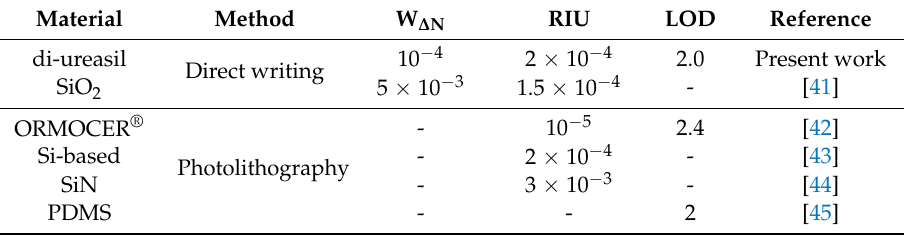
Table 1. Refractive index contrast, sensitivity (RIU), and limit of detection (LOD, pg · mm − 3 ) of selected MZI optical biosensors using the intensity methodology. The method used to fabricate the sensor is also